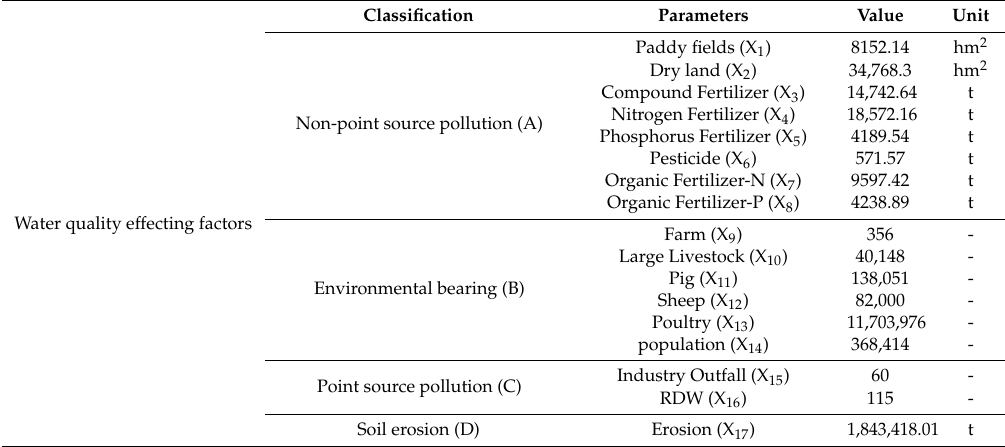
Table 1. Evaluation